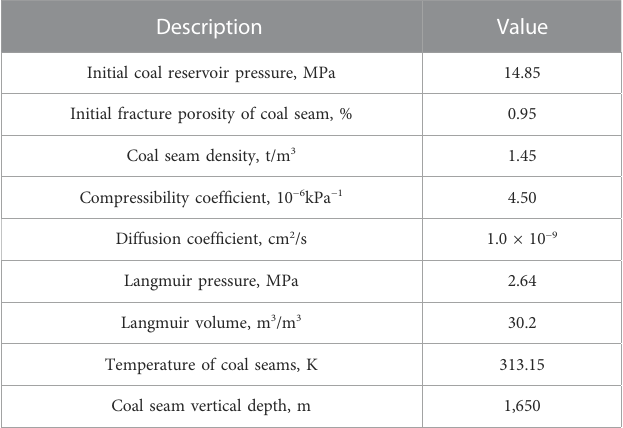
TABLE 1 Basic parameters of coalbed methane